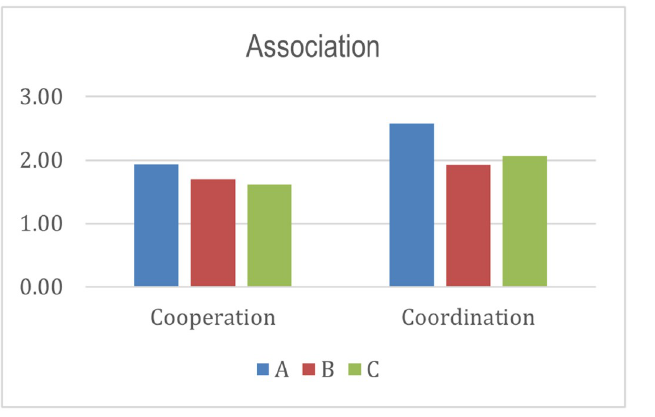
Fig 8. Index score of